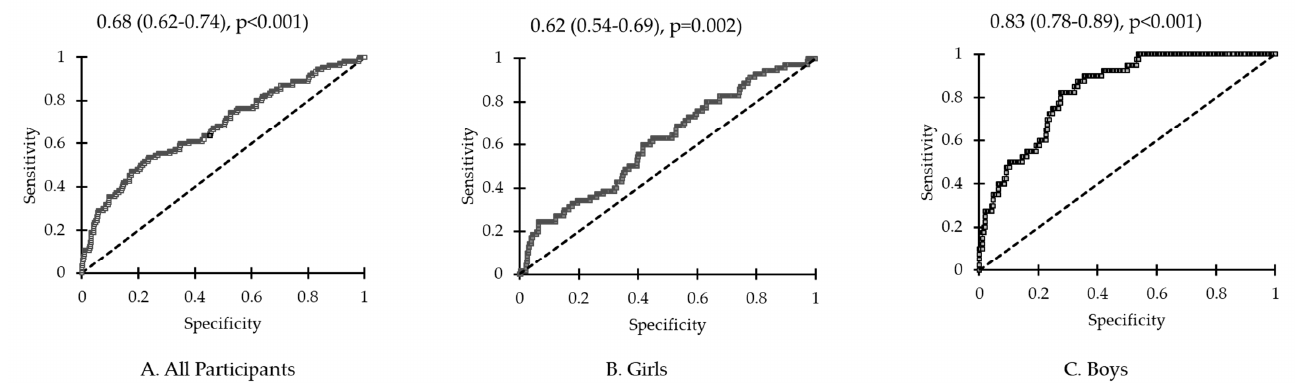
Figure 2. Receiver operating curve for NOx in ( A ) all participants, ( B ) girls and ( C ) boys.